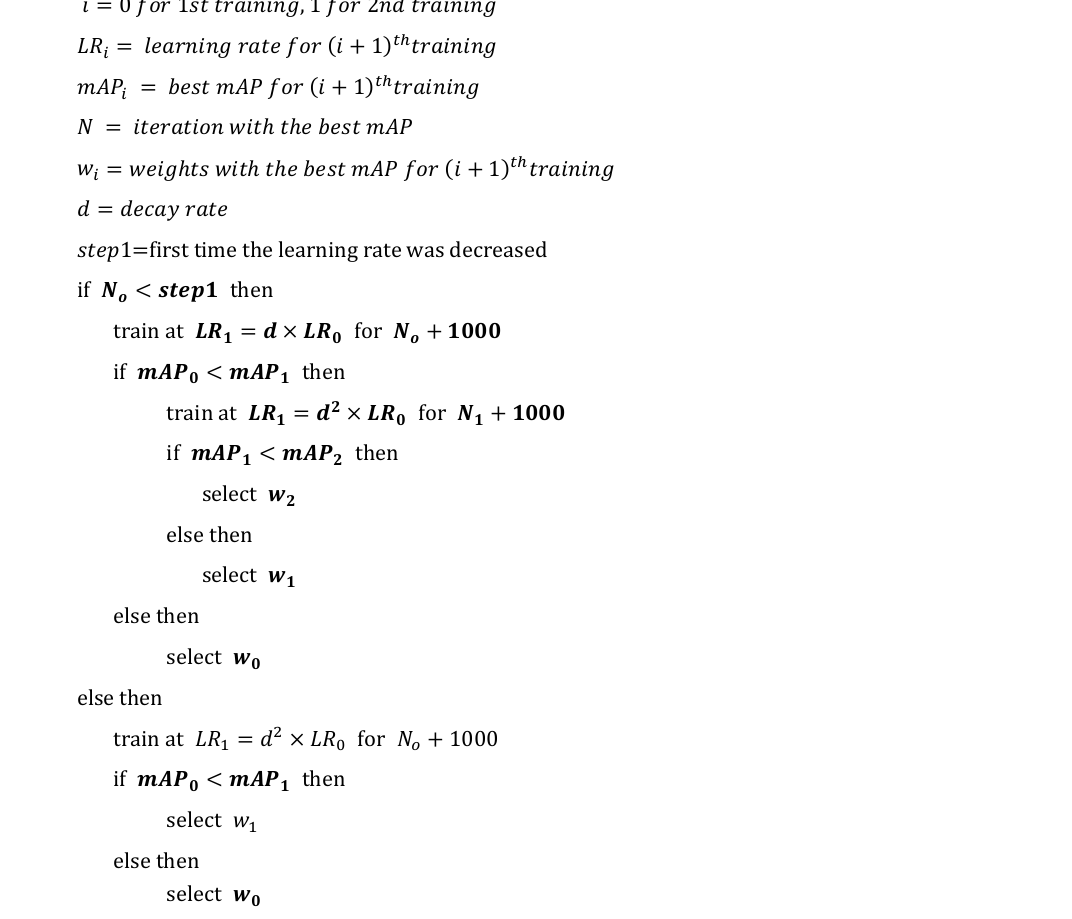
Algorithm A1 . Pseudocode of the fine-tuning process in Stage 2 training of the YOLOv4 models.